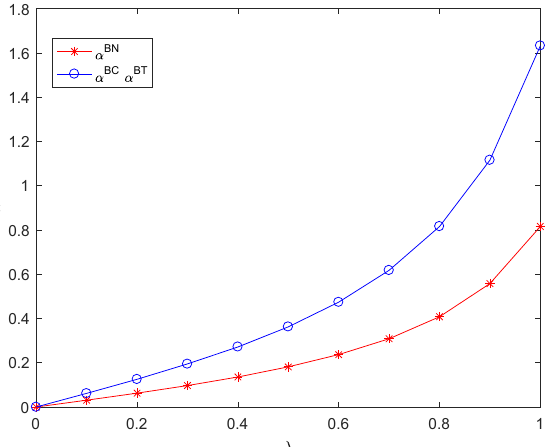
Figure 3. The quality of information disclosure in two types of contracts.